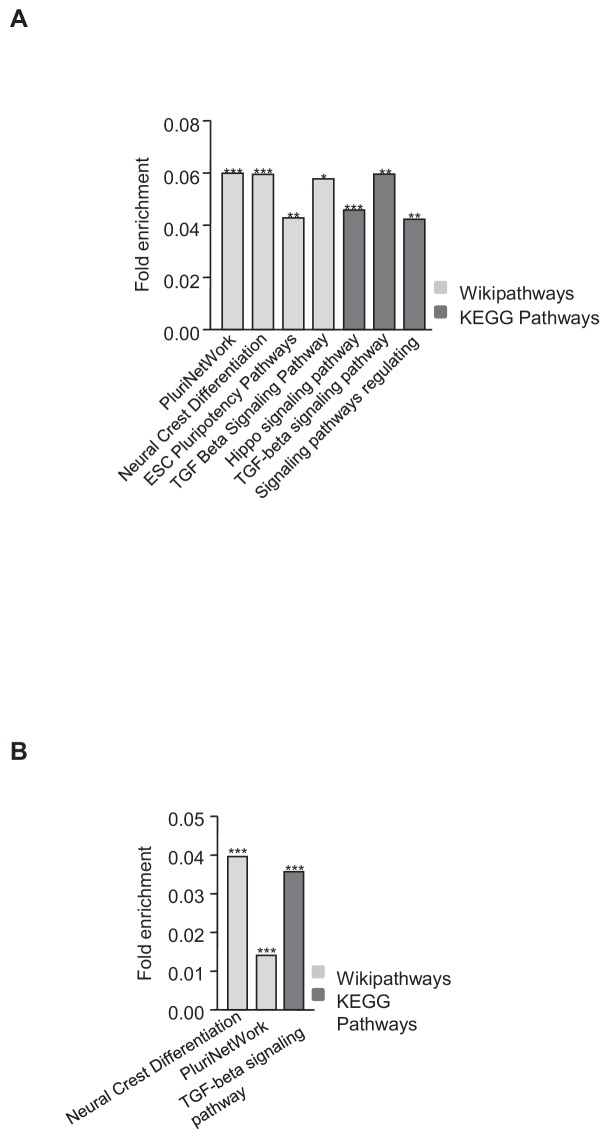
Functional analysis of genes downregulated in the absence of TRF1 that show recruitment of SUZ12 and H3K27me3.(A) KEGG and Wikipathways analyses of genes downregulated in the absence of TRF1 that show recruitment of SUZ12 showed that these genes were significantly enriched in important pathways controlling pluripotency and differentiation. (B) KEGG and Wikipathways analysis of genes downregulated in the absence of TRF1 that show recruitment of H3K27me3 showed that these genes were significantly enriched in important pathways controlling pluripotency and differentiation. * = p value<0.05; ** = p value<0.01; *** = p value<0.001.